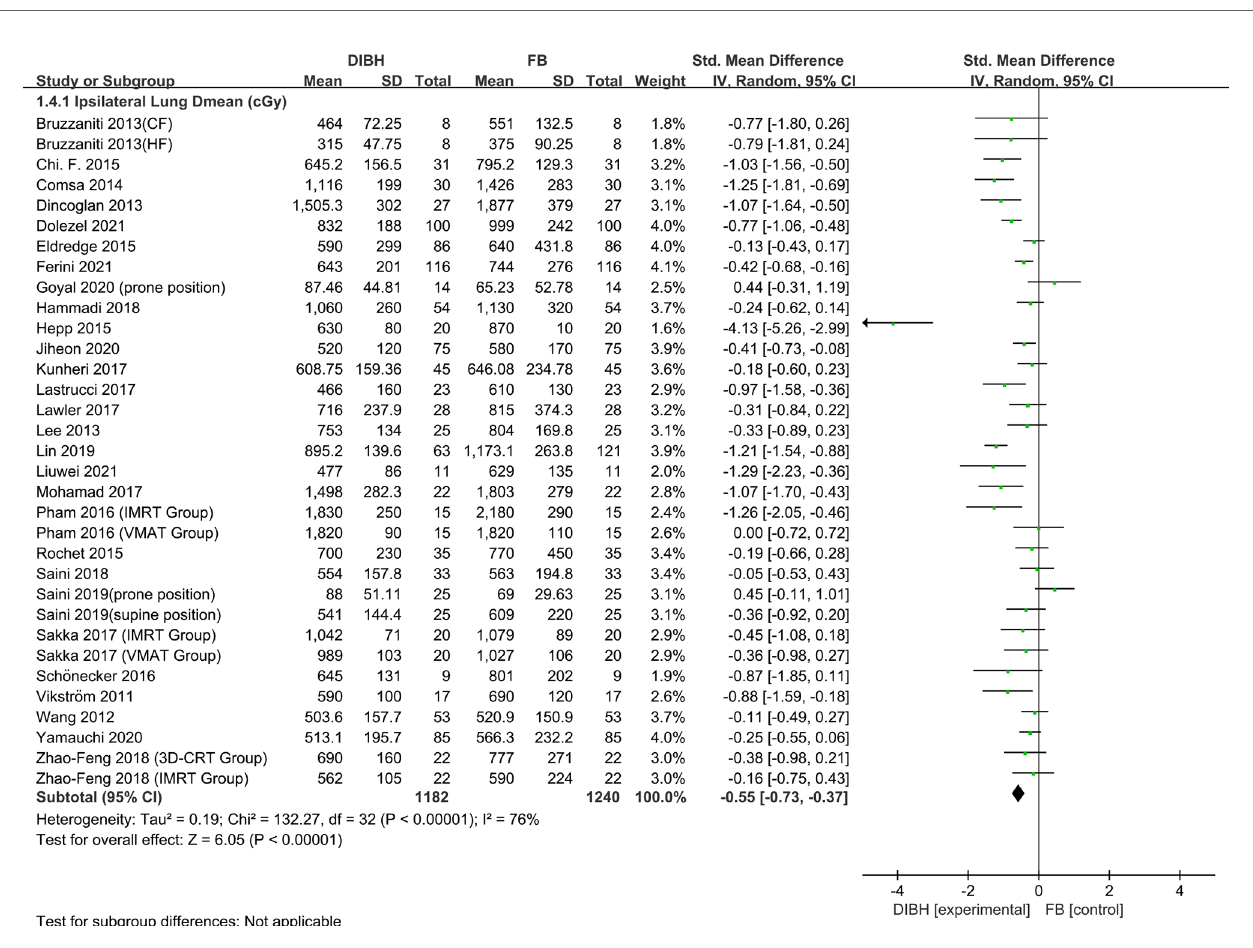
FIGURE 5 | Forest plot of ipsilateral lung dose ( D mean ) between the DIBH group and FB